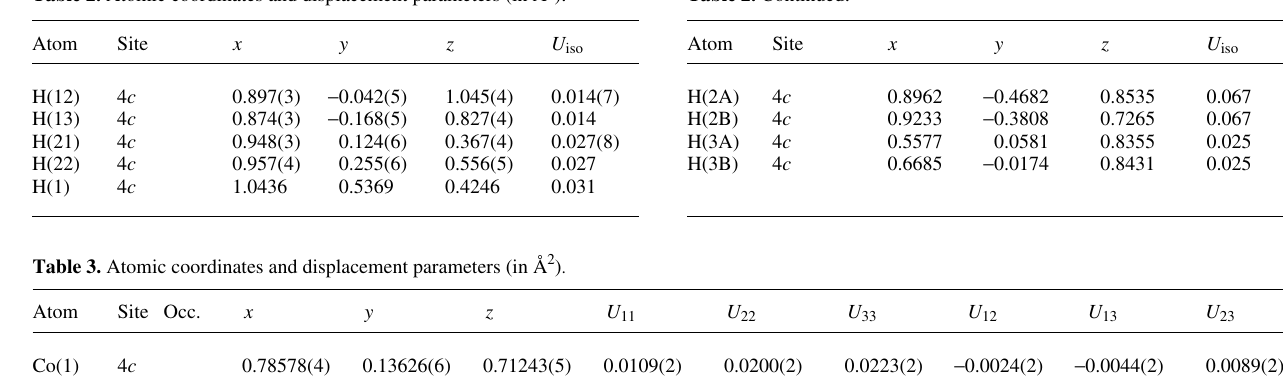
Table 2. Atomic coordinates and displacement parameters (in Å 2 ) .